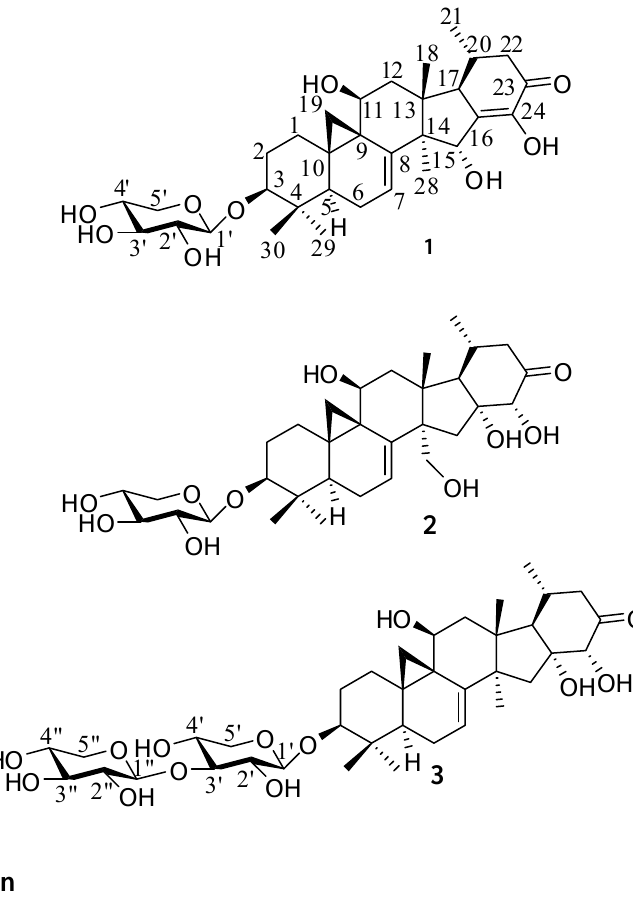
Figure 1. Structures of compounds 1 , 2 and